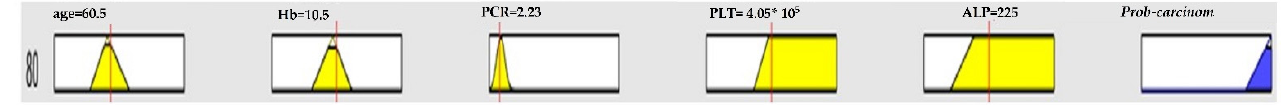
Figure 9. Application of AND operator for rule aggregation.